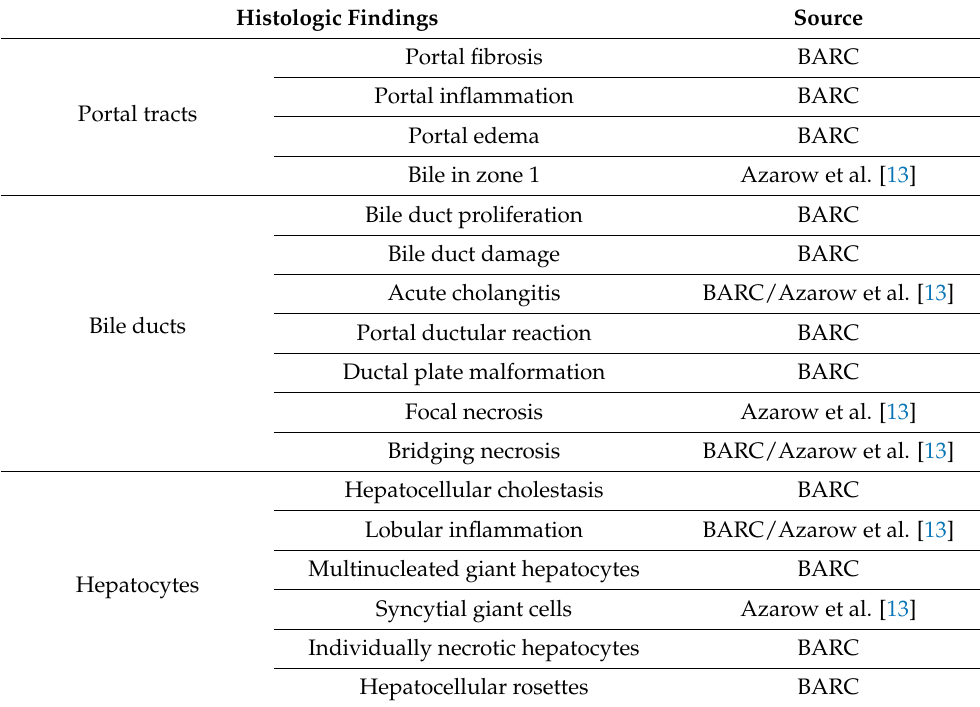
Table 1. List of histologic factors reviewed on liver biopsies as potential predictive factors of outcomes (Legend: BARC: Biliary Atresia Research